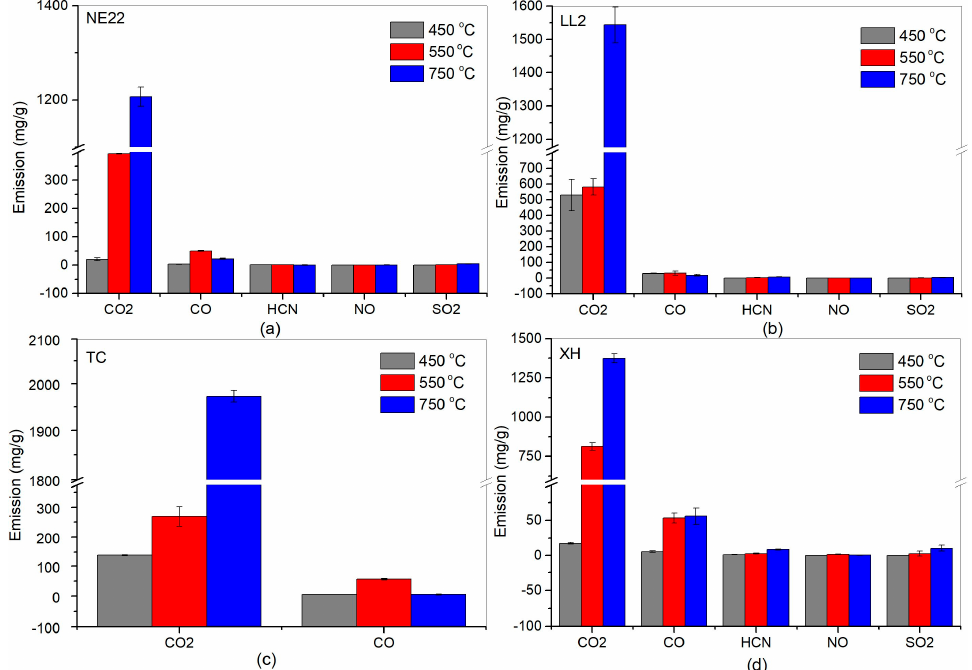
Figure 5. Emission of products during decomposition and combustion of belts at 450, 550, and 750 ◦ C: